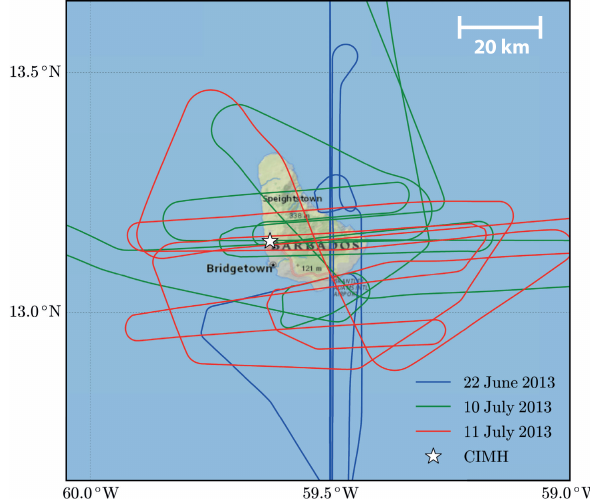
Figure 1. Falcon flight tracks in the Barbados region on 22 June, 10 July, and 11 July 2013. The white star marks the lidar site at the Caribbean Institute for Meteorology and Hydrology (CIMH), located north of the capital Bridgetown. Comparisons of Falcon air- craft versus BERTHA lidar are based on the observations listed in Table